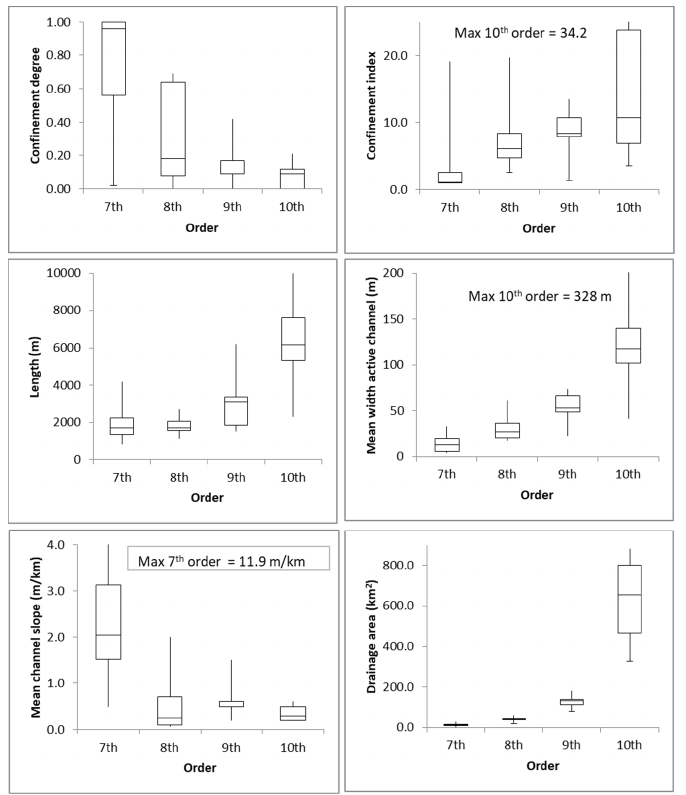
Figure 5. Statistical distributions (1st, 2nd, and 3rd quartiles) as well as minimum and maximum values of the main numeric parameters for reaches of the same order identified in the Dittaino River. Maximum values are given in text boxes to make the figure more readable.